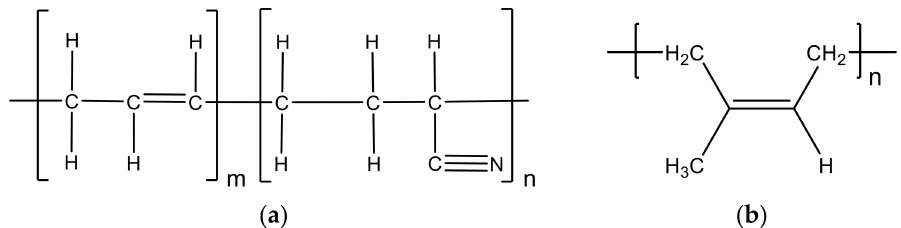
Figure 13. Chemical structures of: ( a ) Acrylonitrile butadiene rubber, and ( b ) natural rubber or poly-cis-isoprene (n, m: Number of repeat